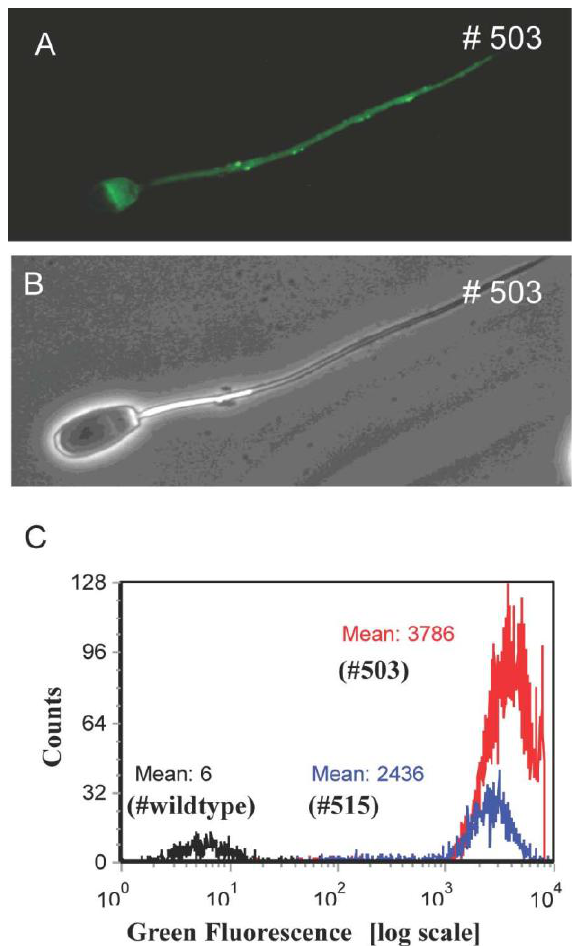
Figure 3. Expression of Venus fluorescence in spermatozoa. (A) Specific Venus fluorescence of a spermatozoon from F0 boar #503; (B) Brightfield image of A; (C) Flow cytometric analysis of pig spermatozoa. The black line in the FACS analysis represents wild type sperm; blue line, spermatozoa from F1 boar with single integration; red line, spermatozoa from boar #503 with three integrations. Note that all spermatozoa from the transgenic pigs are uniformly